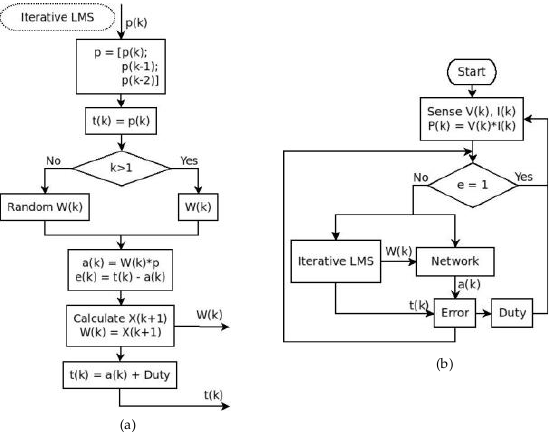
Figure 8. Flow diagrams: ( a ) Iterative LMS Algorithm; ( b ) Iterative LMS Controller.